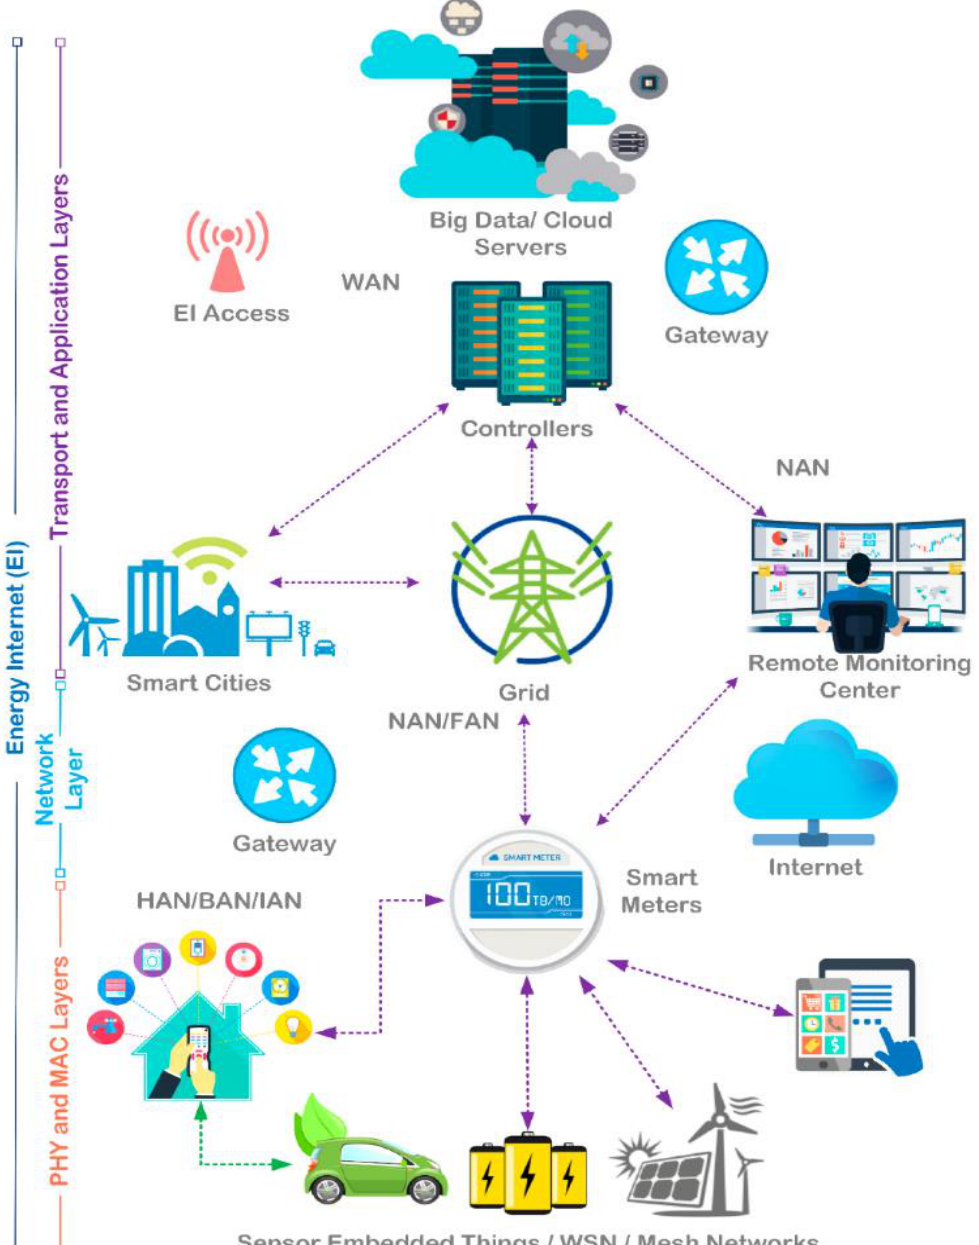
Figure 18. The Internet of Things and energy internet-based smart grid platform (Reprinted with permission from [143], 2019, MDPI). (Note: WAN—wide area network, NAN—near-me area network, FAN—flexible access network, HAN—home area network, BAN—body area network, IAN—Internet area network, WSN—wireless sensor network, PHY—physical, MAC—media access control).